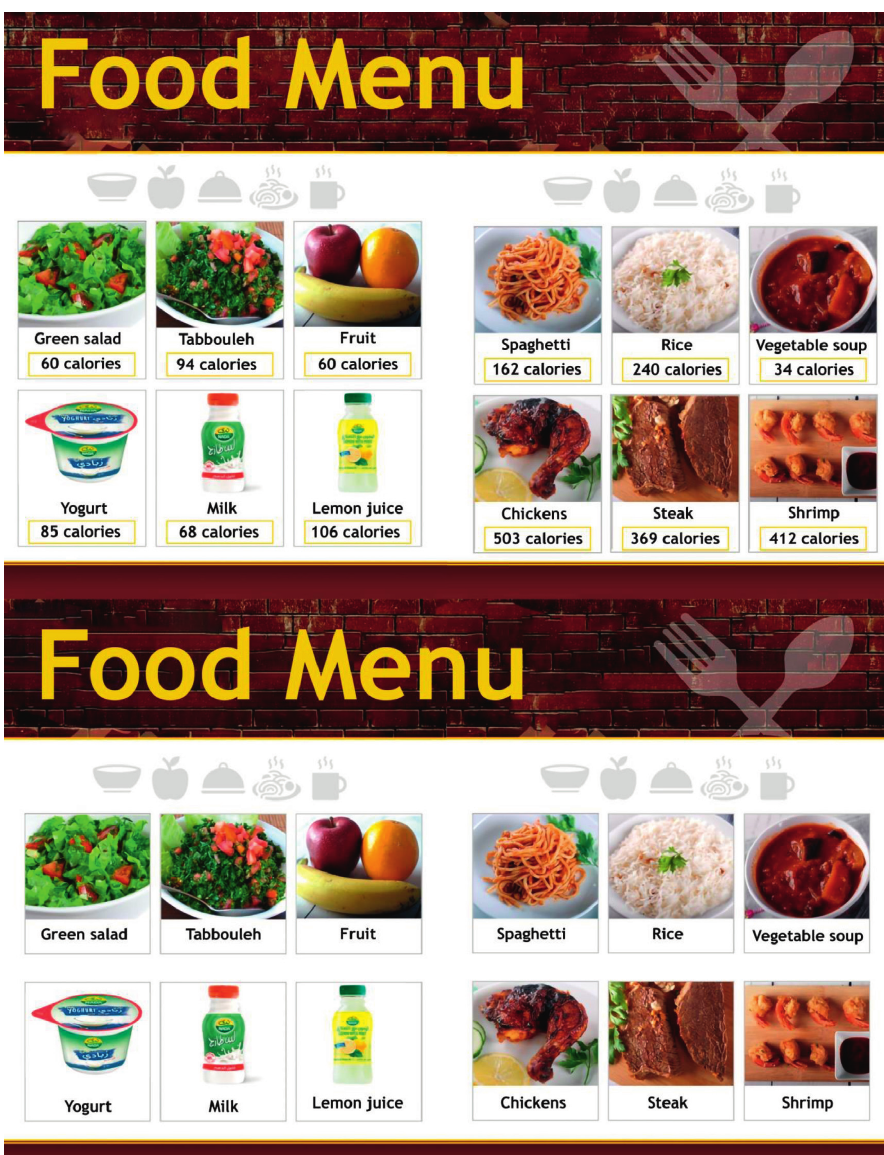
Figure 2: Menus without and with calorie